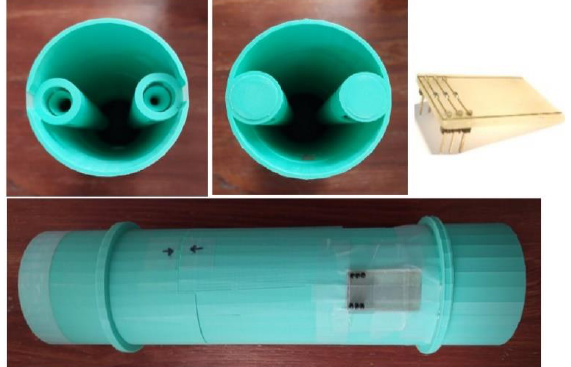
Figure 9. 3D printed sensor housing fabricated with PLA material in combination with PVA sup- portive material; the PT100 RTDs-integrated on PCB substrate are also presented (upper right im- age).